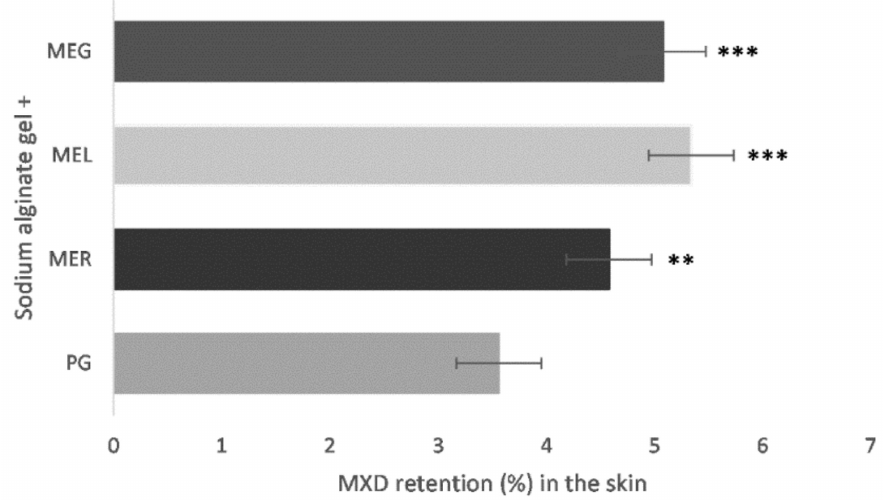
Figure 6. MXD deposition in the skin after ex vivo permeation from sodium alginate gel (ALG); solubilization in propylene glycol (PG), reference ME R , lecithin-containing ME L or gelatin-containing ME G . Significantly different data against reference (PG) are at p < 0.01 (**) and p < 0.005 (***). This method appears to be the optimal for evaluation of penetration enhancer’s effectivity. It clearly depicts the enhancer ability to promote drug permeation into the